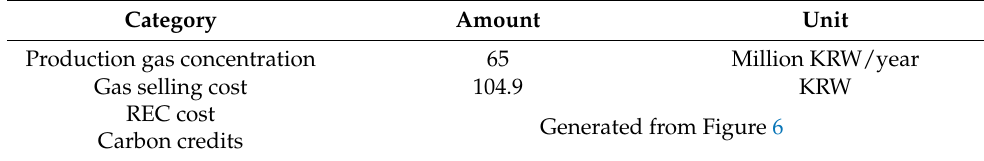
Table 7. Assumed definition.